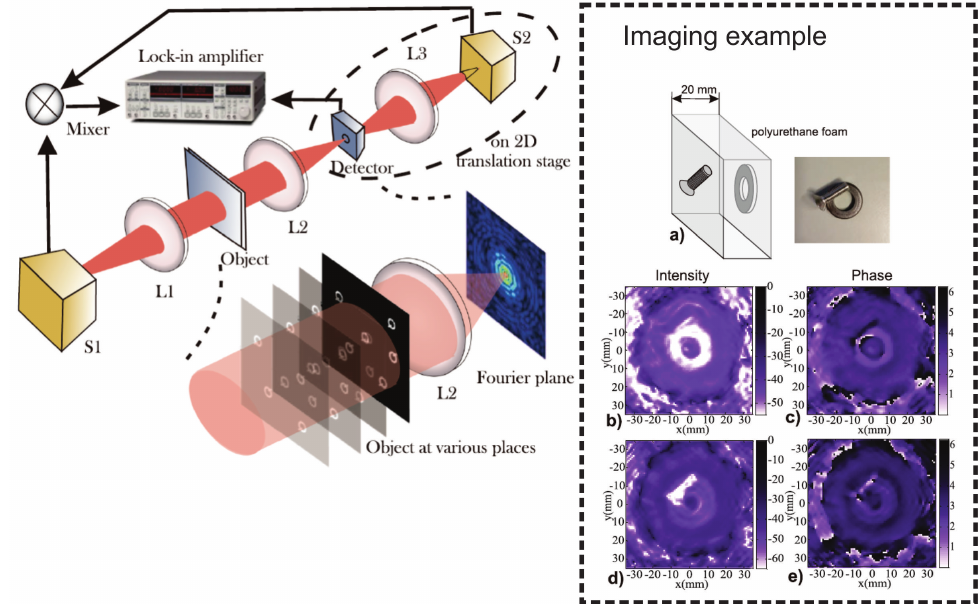
Figure 5. Schematic of the Fourier imaging based on the heterodyne detection of nanometric FET detector at 300 GHz. Left inset: Sketch of the imaging setup. The scene is illuminated by radiation from source S1. The spatial Fourier spectrum of the scene is written in the focal plane of lens L2 (as indicated by the schematic on the lower right side of the figure) and recorded with the raster-scanned single-pixel detector. S2 works as local oscillator and is focused onto the front side of the detector by L3. L3 and S2 share the translation stage with the detector and are moved together with it (as symbolized by the dashed ellipse). Right inset: 3D imaging example ( a ) Left side: Washer-and-screw scene. The THz beam impinges from the left and hits first the screw and then the washer. Right side: The photograph of the washer and screw placed on a table with approximately correct projectional view. Middle panels: Intensity ( b ) and phase images ( c ) for a reconstruction distance equal to the position of the washer; lower two panels: Reconstructed intensity ( d ) and phase ( e ), but for the distance equal to that of the screw. Figure modified from Ref.